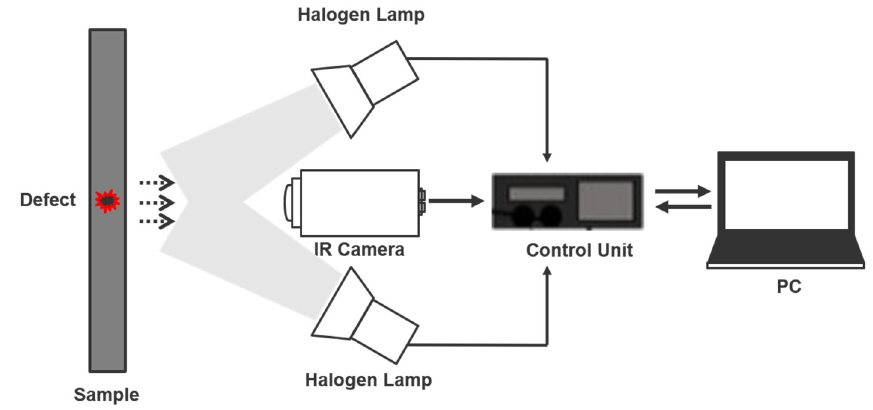
Figure 4. Experimental configuration of a lock-in thermography inspection system.